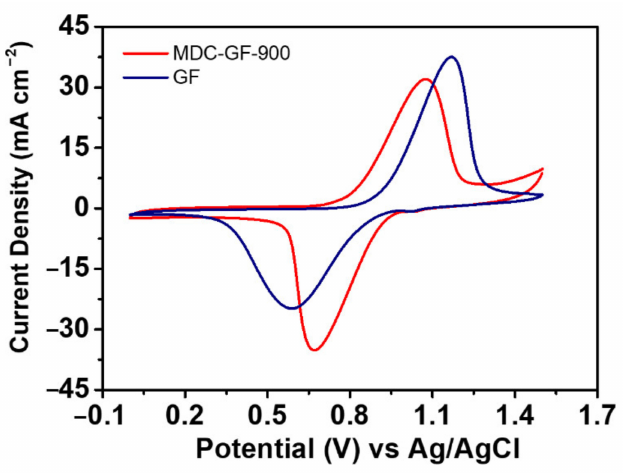
Figure 7. CV curves of MDC-GF-900 and pristine GF obtained at the scan rate of 5 mV s − 1 . The electrolyte was composed of 0.05 M VOSO 4 plus 2.0 M H 2 SO 4